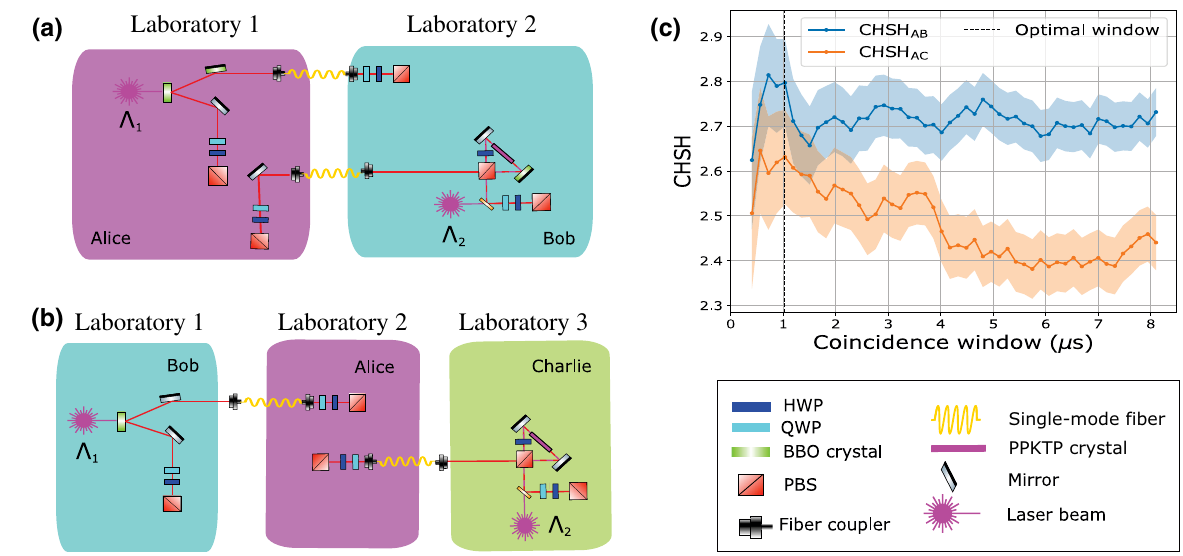
FIG. 2. Experimental apparatus and detection of fourfold coincidences. (a) Parallel self-testing scenario implementation. In this scenario, there are two laboratories, both equipped with a quantum state source and two measurement stations. The measurement stations in laboratory 1 represent Alice, while those in laboratory 2 represent Bob. Both sources generate an entangled pair of pho- tons, and the noise model for the states of (cid:7) 1 and (cid:7) 2 , taking into account the presence of both white noise and colored noise, is as